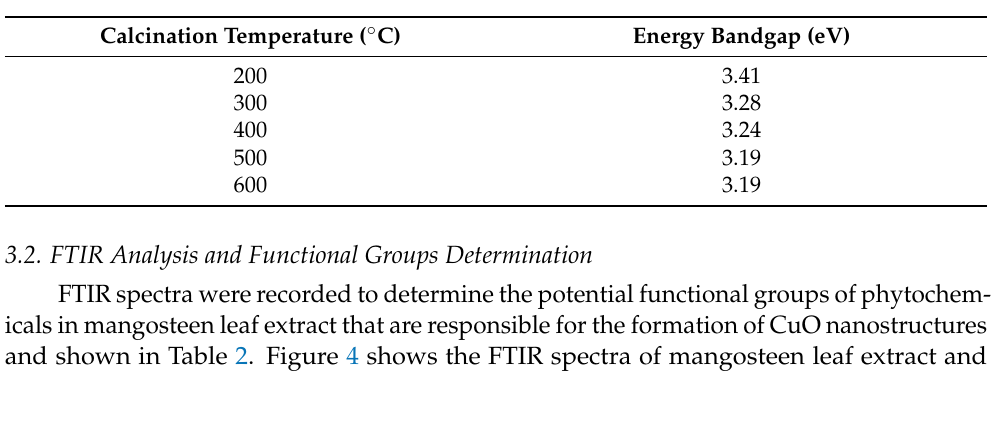
Table 1. Relationship between energy bandgap and calcination